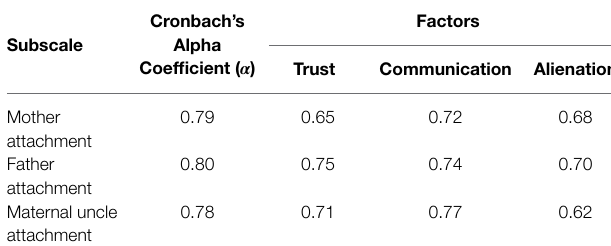
TABLE 1 | Reliability analysis of subscales of IPPA in Study